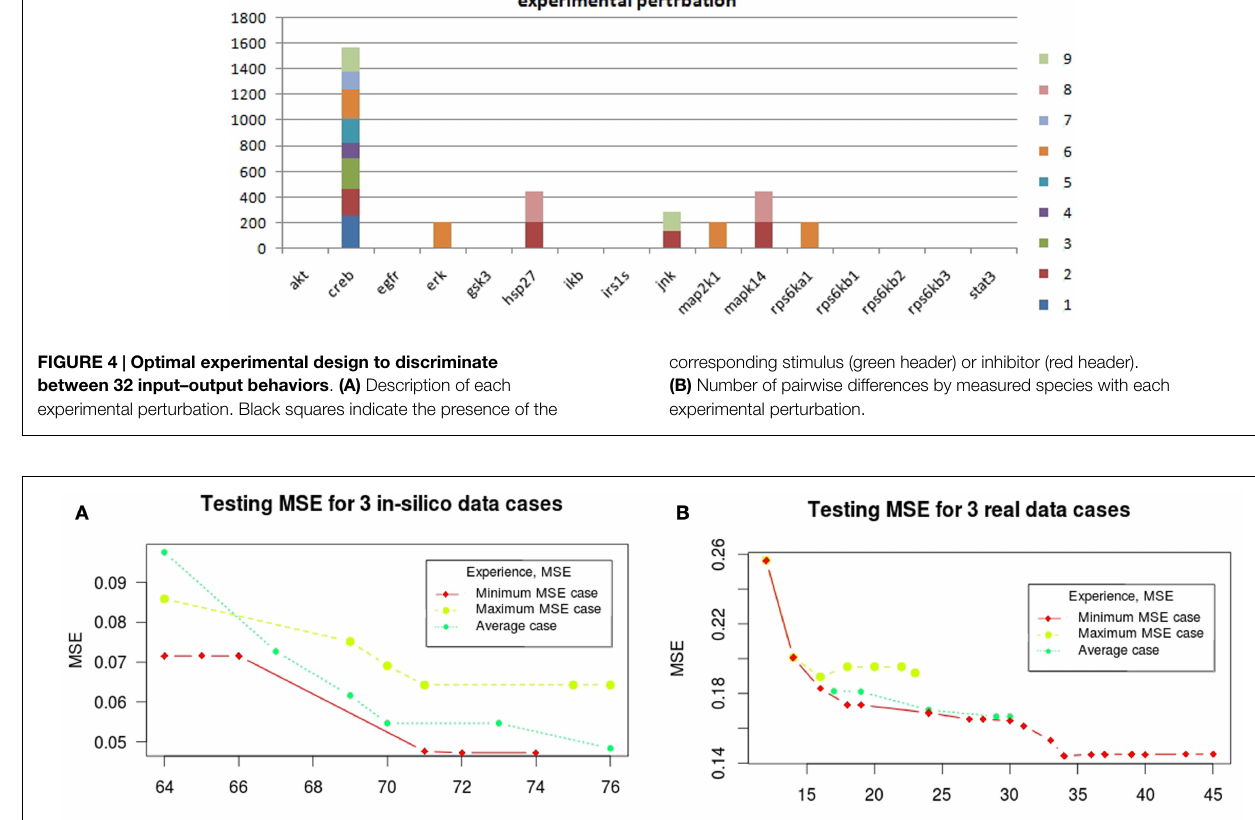
FIGURE 5 | Trajectories of the testing MSE for three significative cases for in silico (A) and real (B) phosphoproteomic datasets: the case where a maximum testing MSE was found, where an average testing MSE was found, and when the minimal testing MSE was found . The X -axis shows